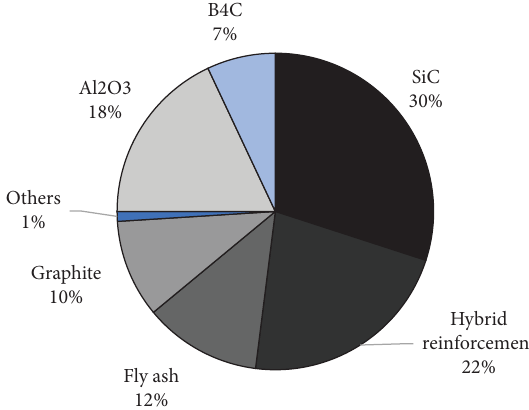
Figure 4: Research on reinforcement’s contribution in wt%